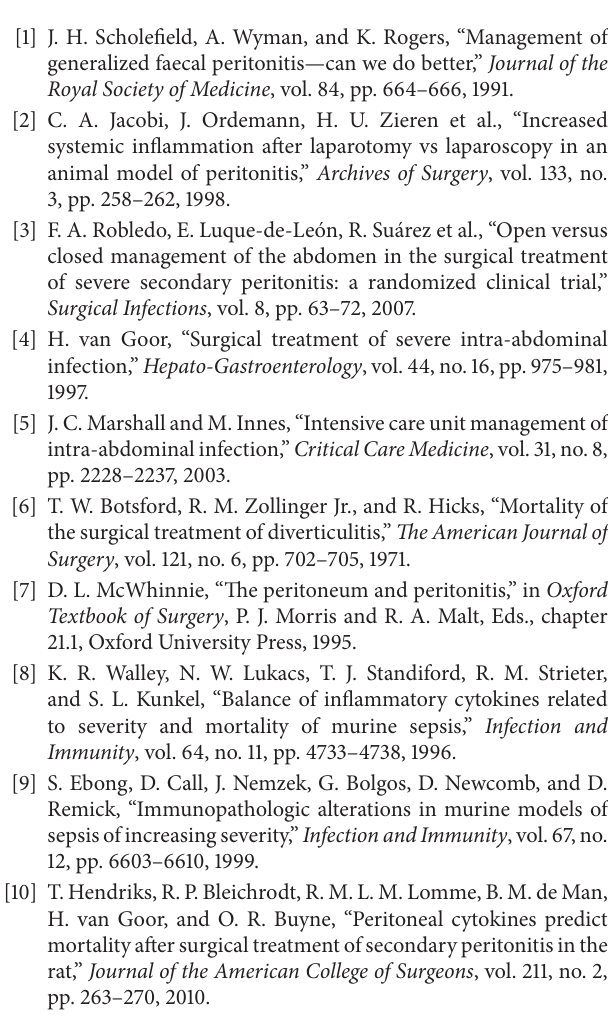
Figure 5: Perioperative platelets (PLT) levels in blood plasma.